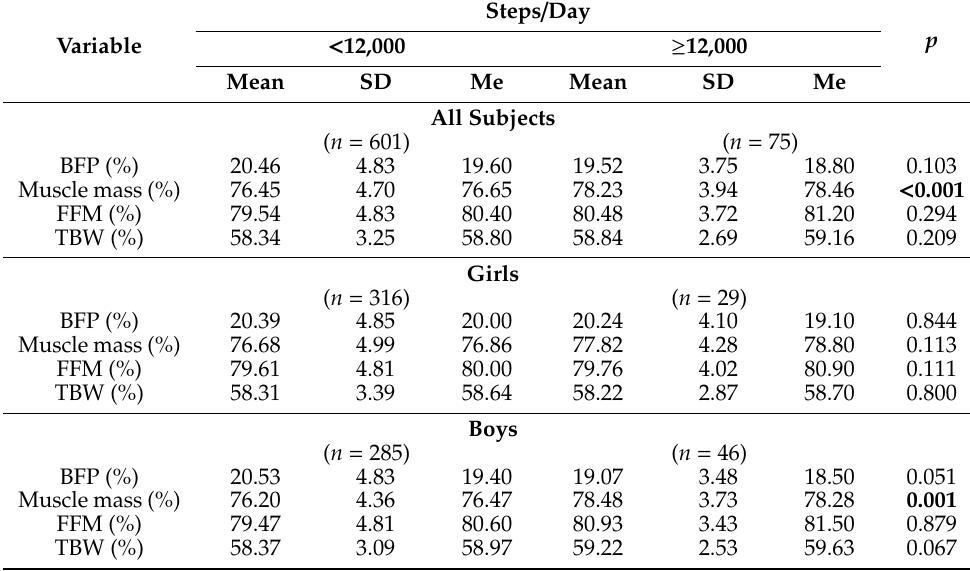
Table 3. Body composition among children with di ff erent numbers of steps per day.